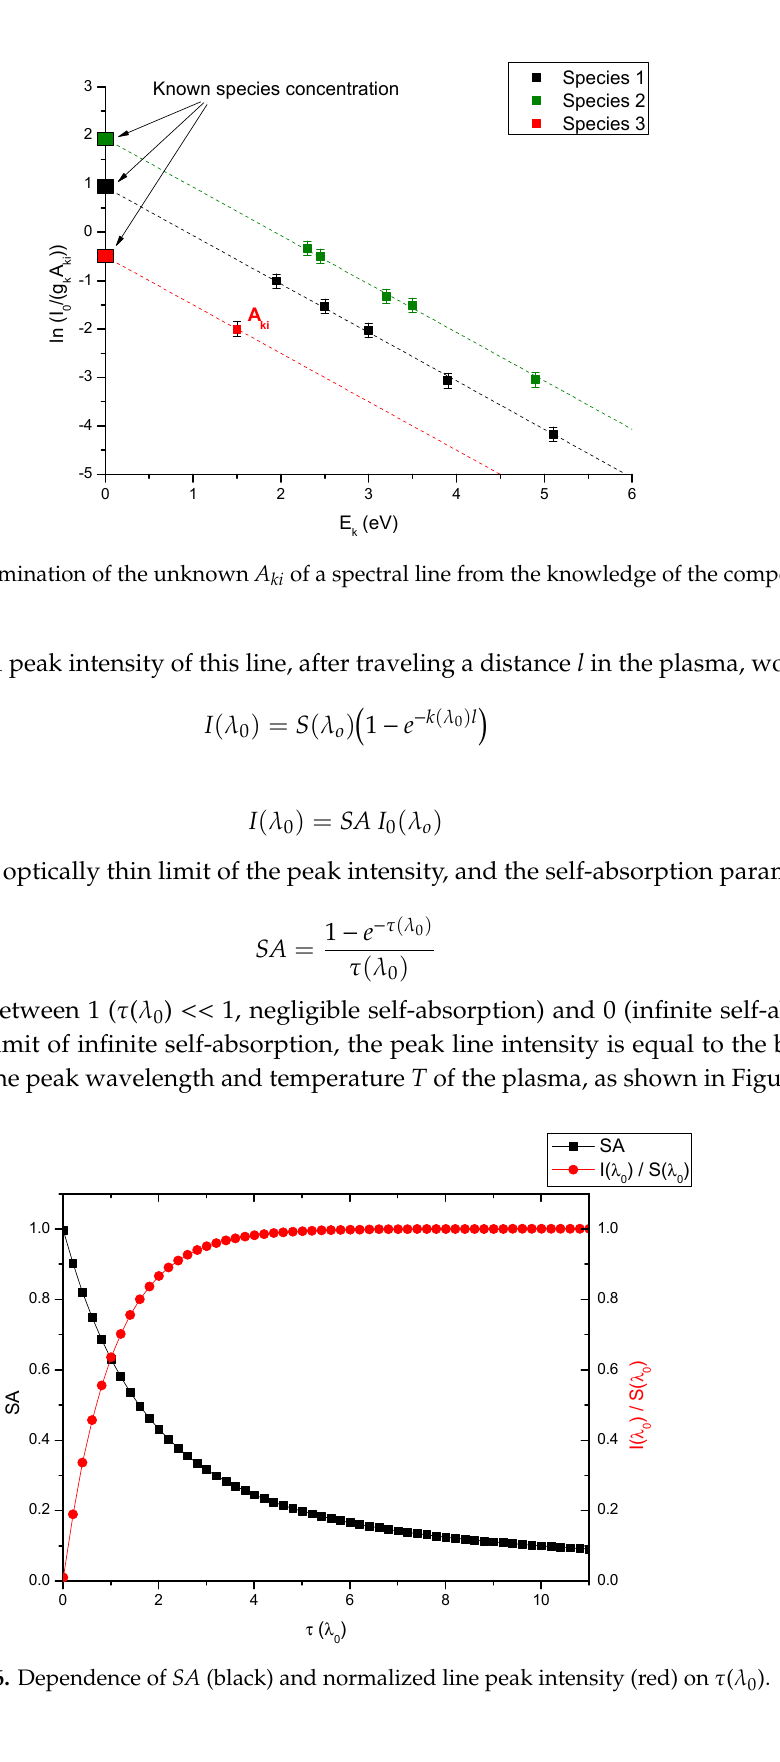
Using a calibration-free LIBS approach [53], the unknown A ki can be determined even when